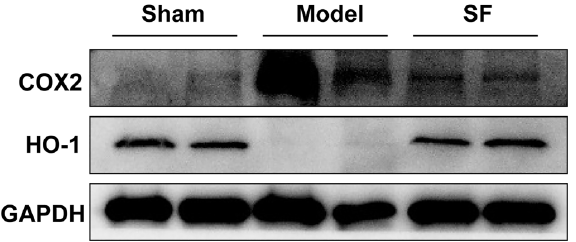
Figure 3. Western blot analysis results show the activation of cyclooxygenase-2 (COX2) expression and down-regulation of heme oxygenase-1 (HO-1) expression in model group (lanes 3 and 4) compared to Sham. After the sodium ferulate (SF) treatment, the results (lanes 5 and 6) were reversed and the COX2 and HO-1 expression levels were similar to the sham group (lanes 1 and